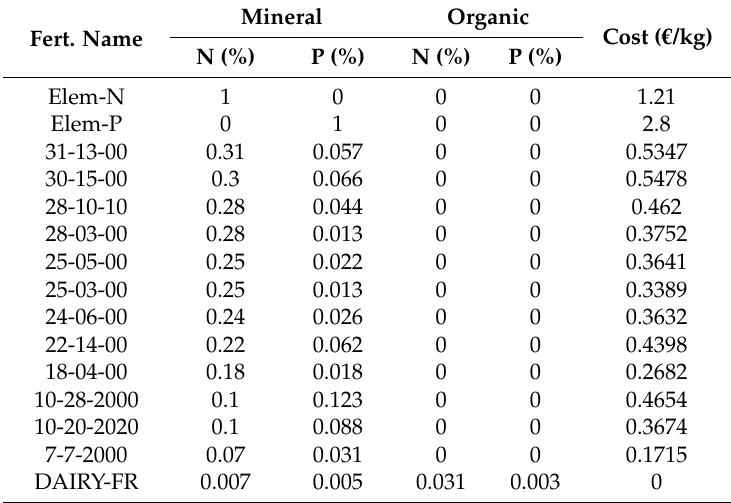
Table 4. Fertilizer prices used for Upper Danube derived from USDA